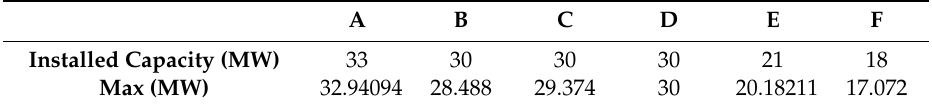
Table 3. Data from wind farms in Jeju Island.